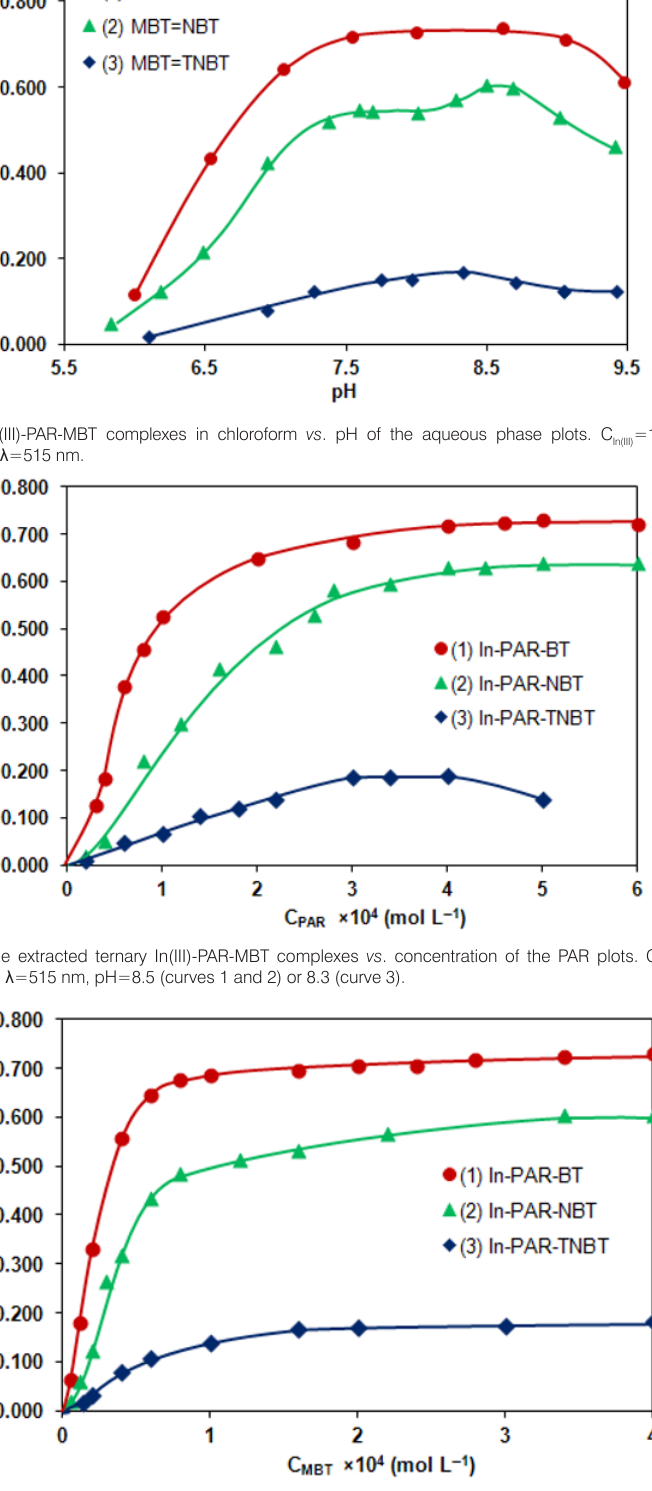
Figure 4. Absorbance of the extracted ternary In(III)-PAR-MBT complexes vs . concentration of the MBT plots. C C =4.0×10 −4 mol L −1 , λ =515 nm, pH=8.5 (curves 1 and 2) or 8.3 (curve PAR